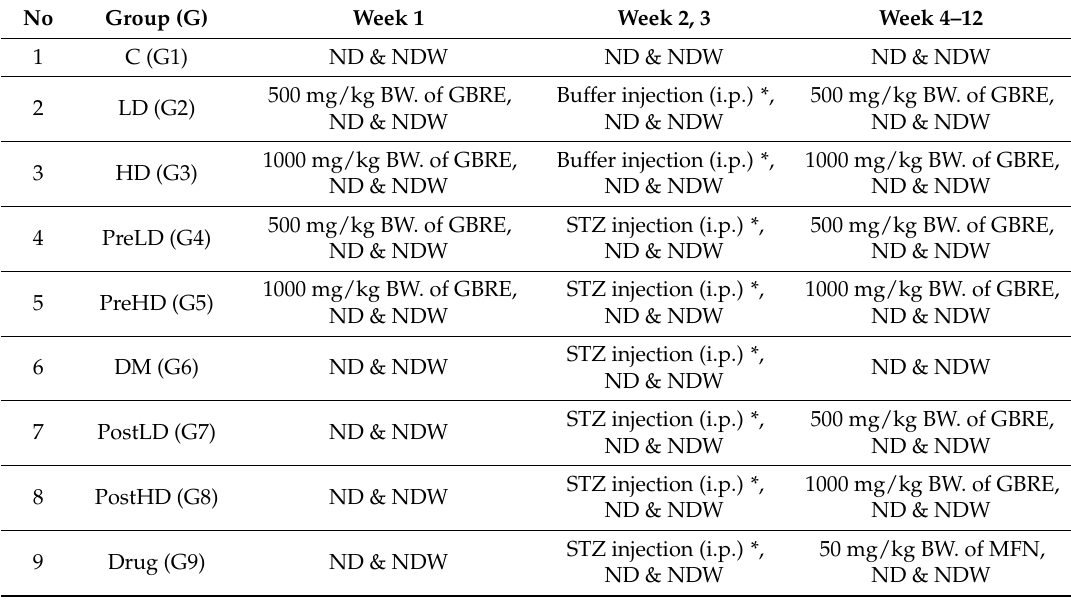
Table 1. The grouping of experimental rats, the dosage of GBRE supplementation and study